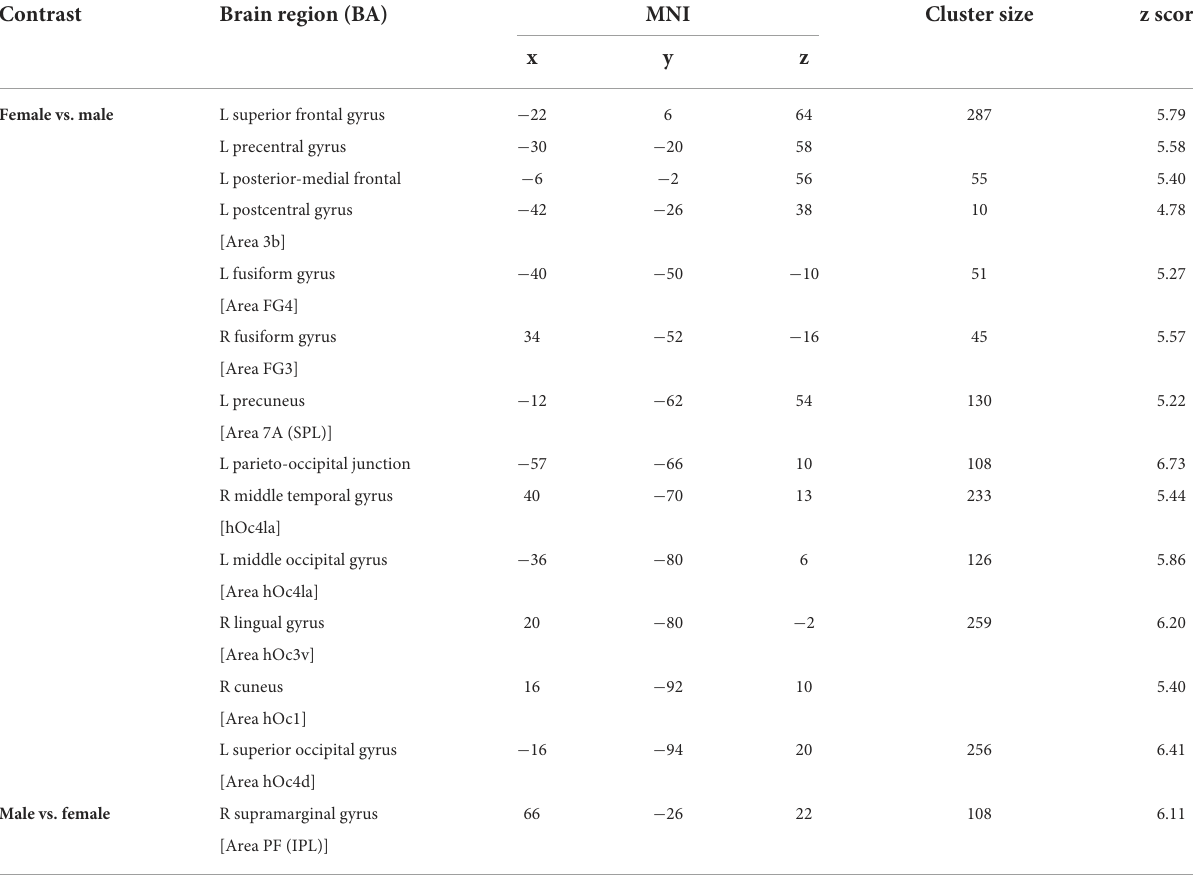
TABLE 1 Significant brain activation of group comparison between female and male participants. Contrast Brain region (BA)